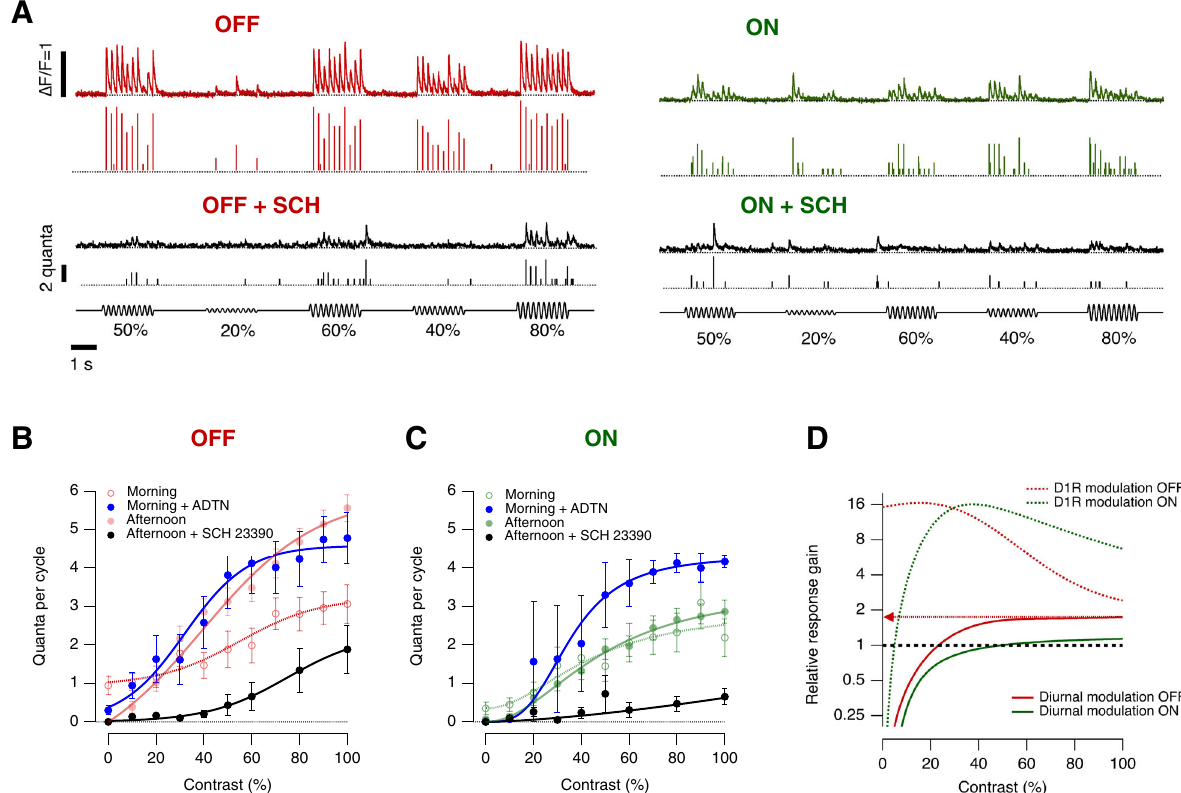
Fig. 3 Diurnal changes in dopamine levels modulate synaptic transmission. A Examples of iGluSnFR signals recorded in the afternoon from an individual OFF (red trace) and ON (green trace) synapses elicited using a stimulus of variable contrast before and after intravitreal injection of the D1 antagonist, SCH 23390 (black traces; estimated fi nal concentration 20 nM). Note that SCH 23390 abolished synaptic responses at lower contrasts in ON and OFF synapses. In each case the top trace shows the iGluSnFR signal and the lower trace the estimated Q e . B Average contrast-response functions in OFF bipolar cell synapses after administration of D1 antagonist (black dots) in the afternoon and after administration of the D1 agonist ADTN in the morning (blue dots). Each point shows the mean ± s.e.m. (SCH 23390, n = 12 synapses; ADTN, n = 12 synapses). Control responses observed in the morning and afternoon are superimposed (red dots, from Fig. 2C). C Average contrast-response functions in ON bipolar cell synapses after intravitreal injection of D1 antagonist in the afternoon (black dots) and ADTN in the morning (blue dots). Each point shows the mean ± s.e.m. (SCH 23390, n = 7 synapses; ADTN, n = 5 synapses). Control responses observed in the morning and afternoon are superimposed (green dots, from Fig. 2D). D Relative response gain by diurnal modulation and after manipulation of dopaminergic signalling (dashed lines). Note that diurnal modulation of synaptic gain is higher in OFF synapses, whereas dopamine modulates the dynamic range by ~16-fold-change in ON and OFF synapses. Source data are provided as a Source Data fi